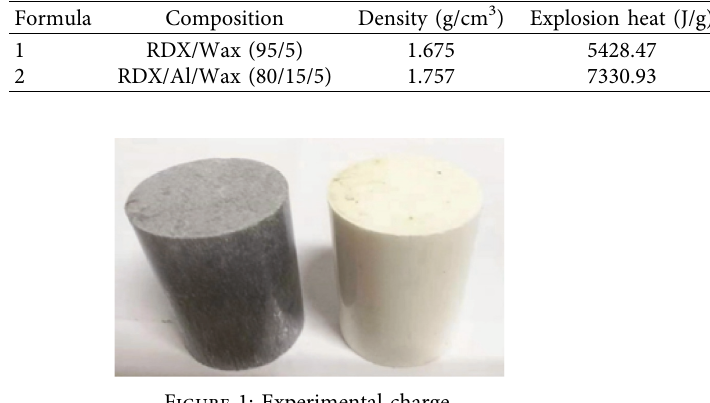
Table 1: Composition and theoretical detonation parameters of experimental charge.